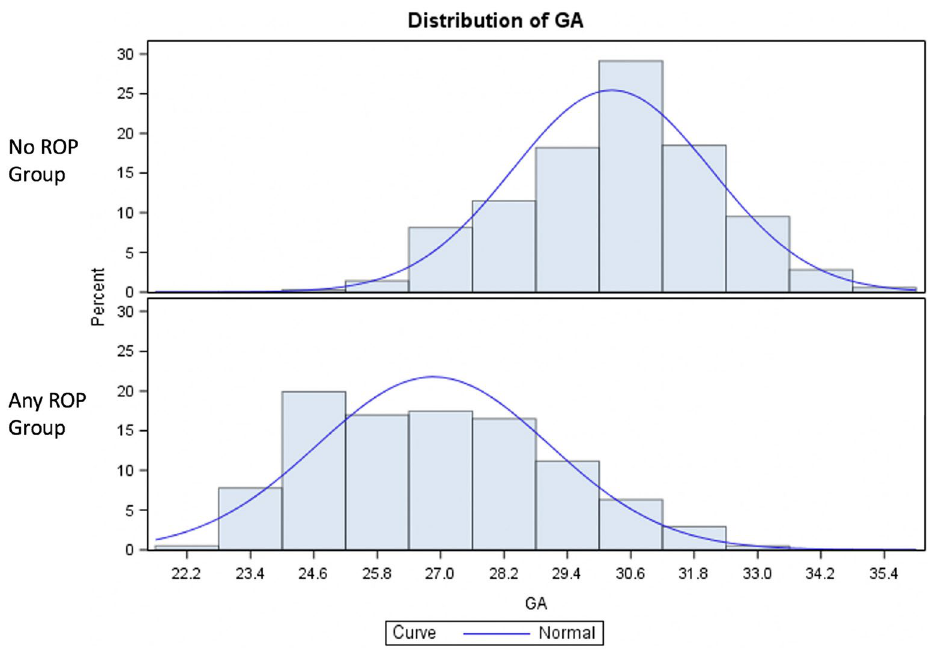
Figure 1. Distribution of Gestational Age in NoROP preterm babies and in all ROP group (Group 1 and Group 2). ANOVA test, p < 0.0001. GA gestational